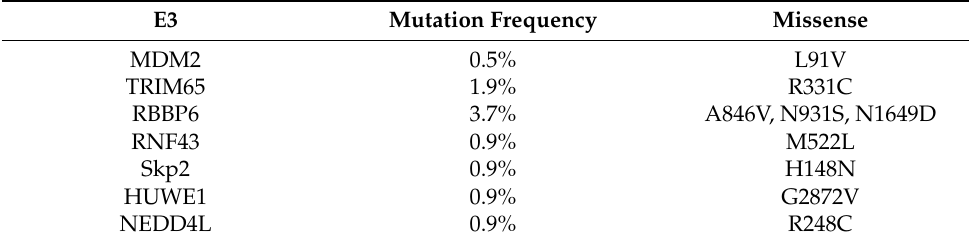
Table 3. Type and site of mutations in